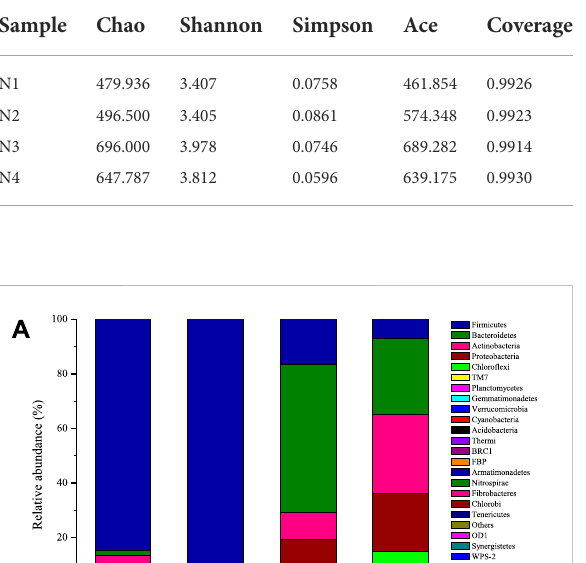
TABLE 3 Indexes of different rarefaction curves.